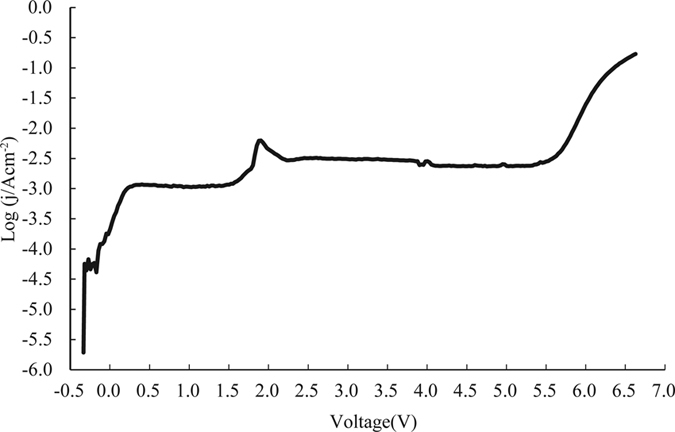
Polarization curve of Ti-6Al-4V in a 10% NaNO3 electrolyte solution.